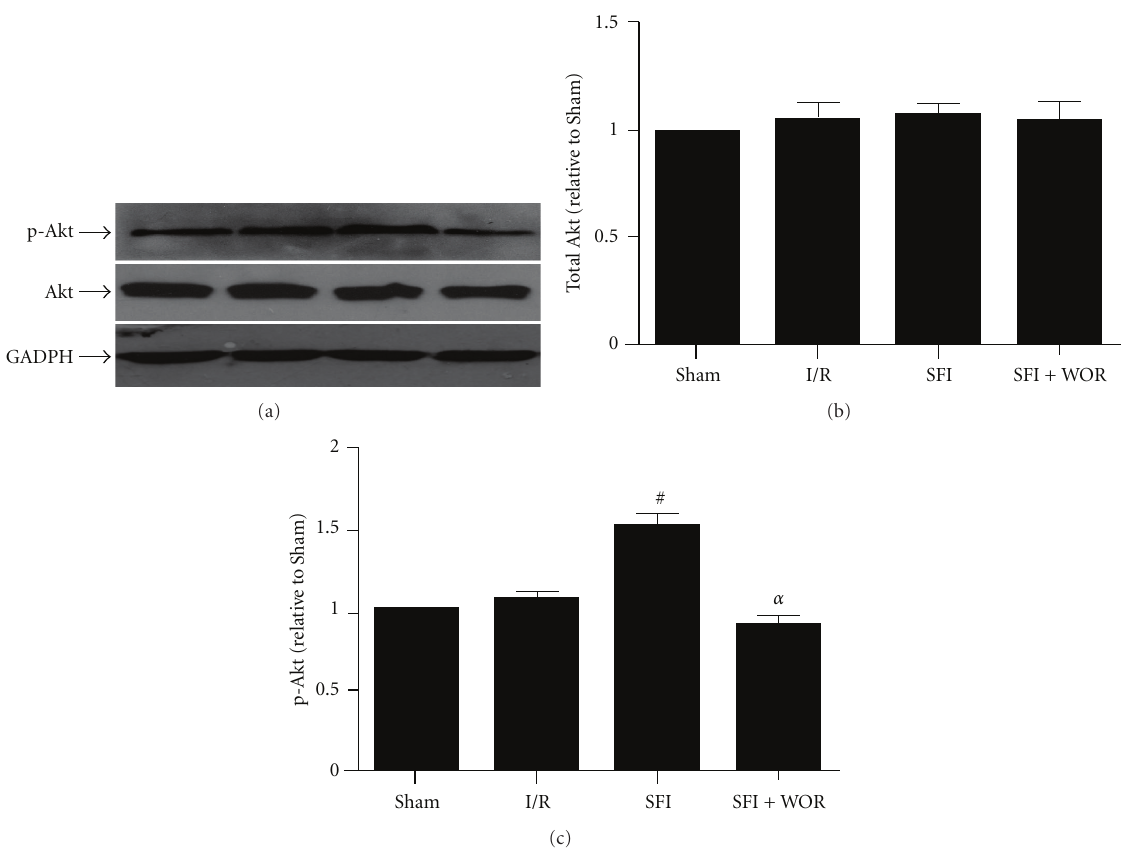
Figure 5: Immunoblots and graphs showing the protein levels and fold increases in total and phosphorylated Akt from Sham, I/R, SFI, and SFI+WOR groups, respectively. I/R: ischemia/reperfusion; SFI: Shen-fu injection; WOR: wortmannin. Values presented are mean ± SEM. n = 6, # P < . 05 versus I/R, and α P < . 05 versus